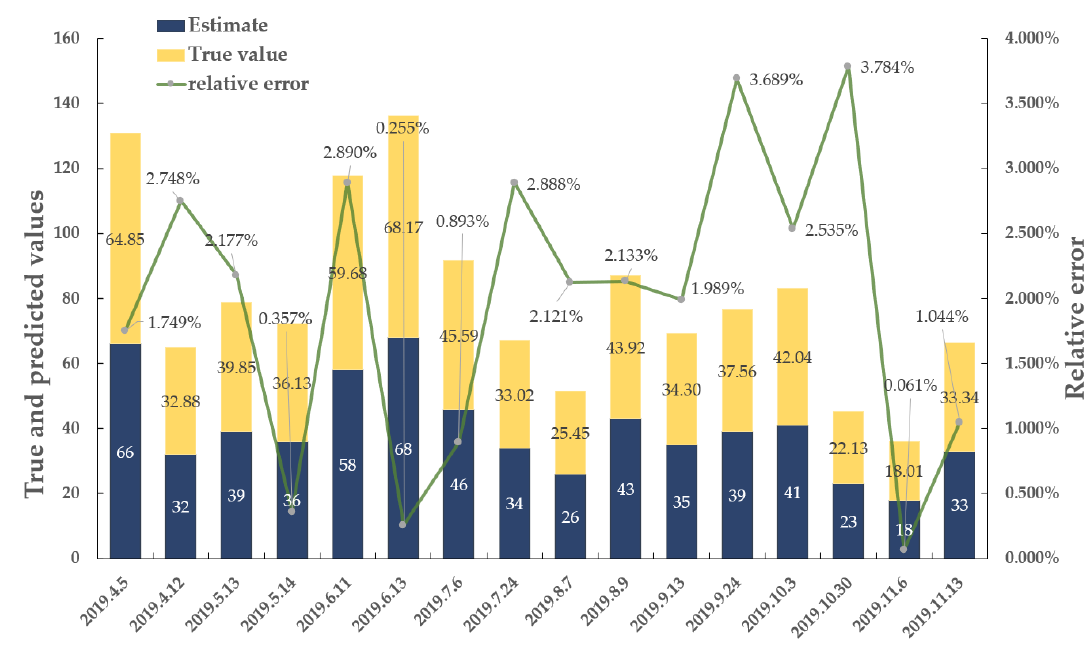
Figure 15. Comparison of predicted evapotranspiration results.